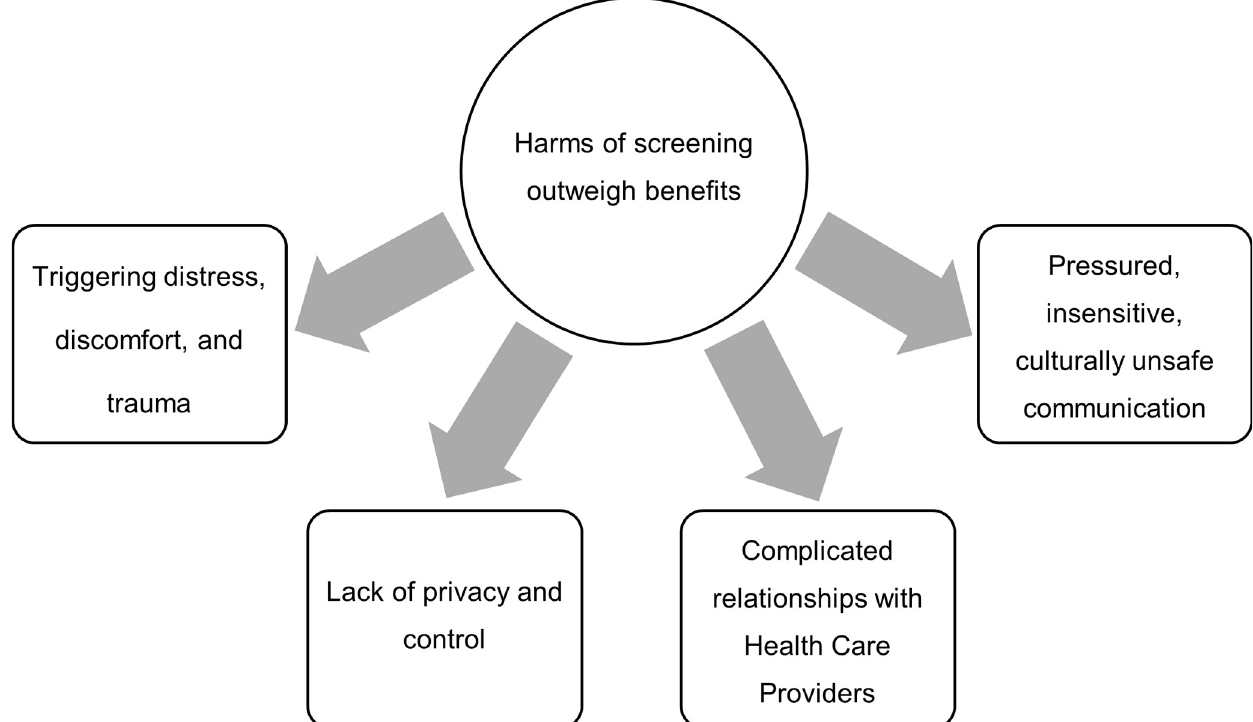
PLOS ONE | https://doi.org/10.1371/journal.pone.0271658 August 31,